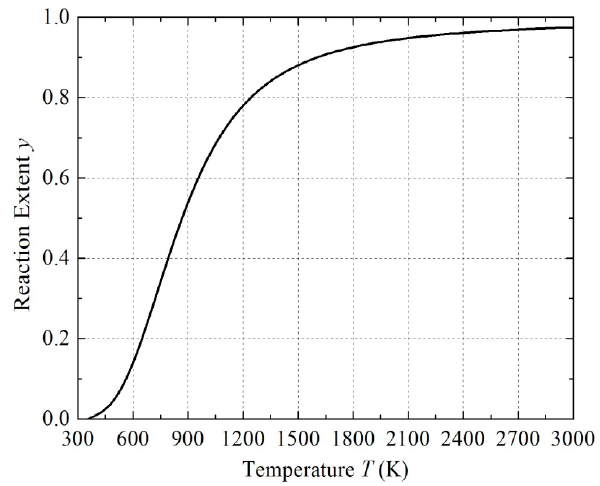
Figure 14. Curve of reaction extent changing with temperature for PTFE/Ti.